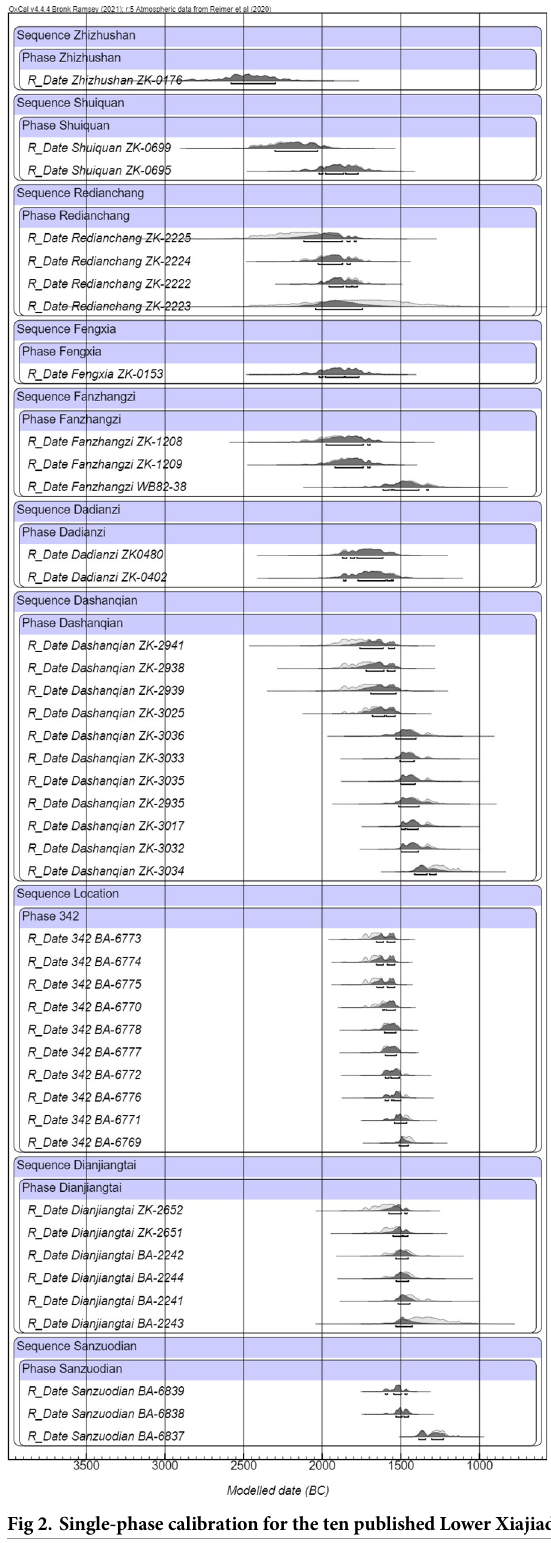
Fig 2. Single-phase calibration for the ten published Lower Xiajiadian sites.